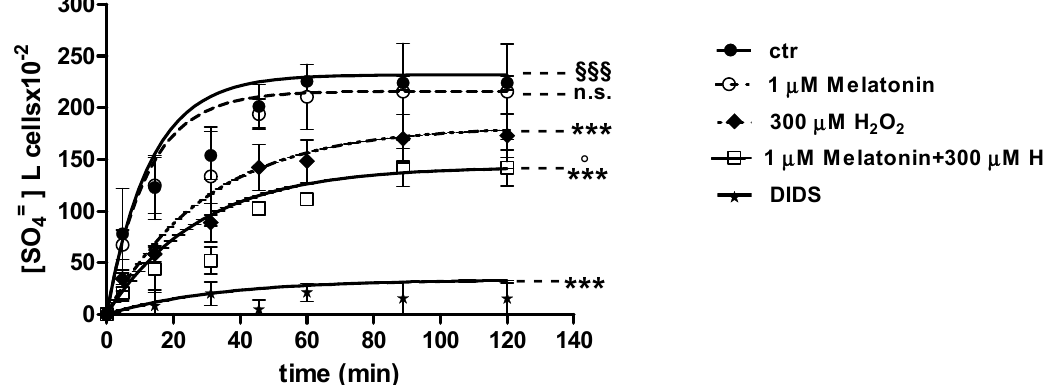
Figure 3. Time course of SO 4= uptake in untreated erythrocytes (ctr) and erythrocytes treated with 300 μ M H 2 O 2 , with or without pre-exposure to 1 μ M Mel. n.s. not significant vs. ctr; *** p < 0.001 vs. ctr, 1 μ M Mel + 300 μ M H 2 O 2 ° p < 0.001 vs. 300 μ M H 2 O 2 , §§§ p < 0.001, as determined by one way ANOVA followed by Bonferroni’s post hoc test (N = 8).